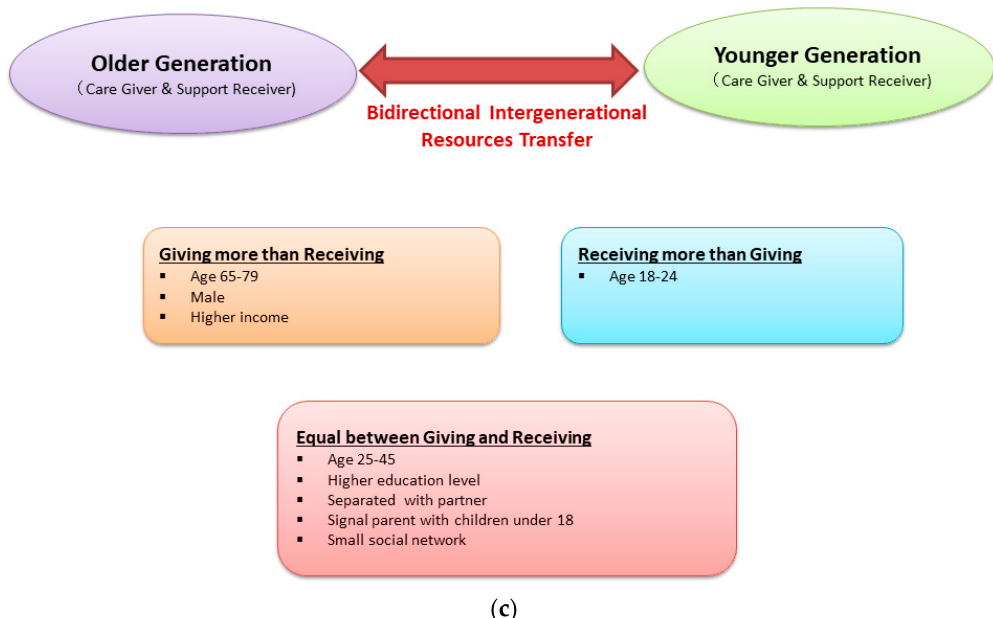
Figure 2. ( a ) Upward intergenerational resources transfer. ( b ) Downward intergenerational resources transfer. ( c ) Bidirectional intergenerational resources transfer.